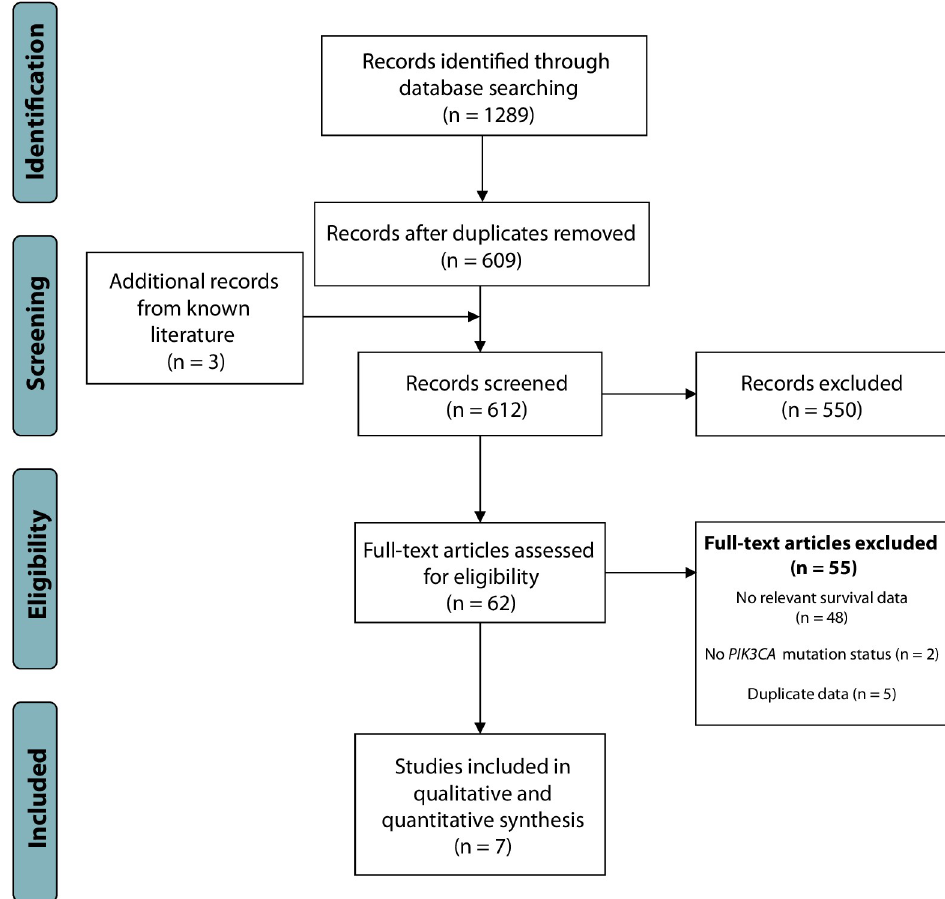
Fig 1. PRISMA flowchart of included and excluded literature. Studies were identified using keyword-based searches in the following databases: CENTRAL, MEDLINE, Embase and Web of Science in the primary search. In addition, publications were manually curated from the COSMIC sequencing